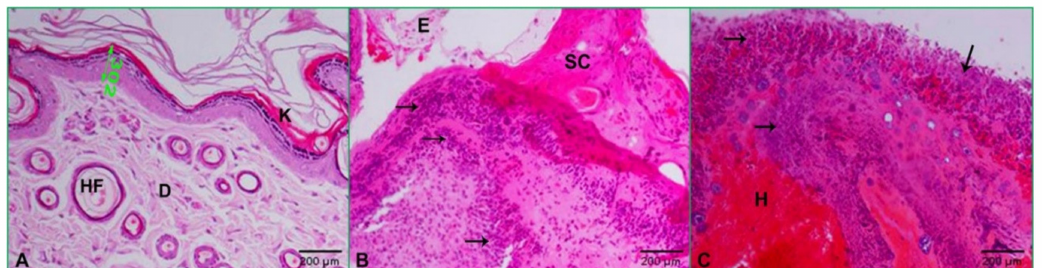
Figure 7. Photomicrographs of skin at day three after wounding: ( A ) control skin showing normal structure with several layers of stratified squamous epithelia (double-headed green arrow = 302 µ m), keratinized layer ( K ), dermis ( D ), the hair follicle ( HF ); ( B ) untreated and uninfected wounded skin displaying edema ( E ), scab ( SC ), and granuloma (black arrows); ( C ) untreated and infected wound revealing wide granulomatous area (black arrows) and hemorrhage ( H ) (HE: 200 ×